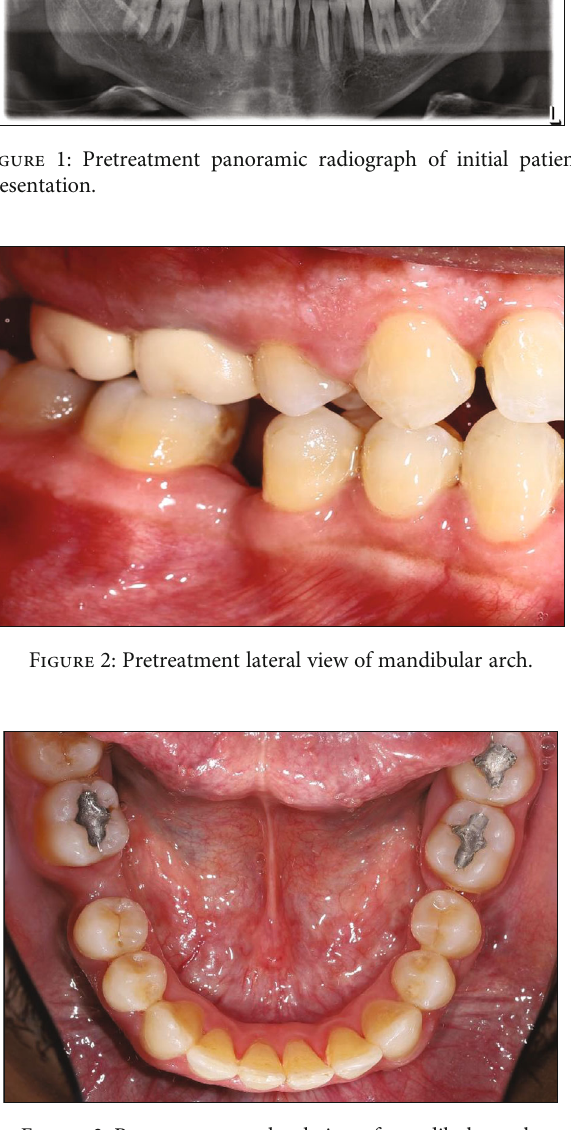
Figure 3: Pretreatment occlusal view of mandibular